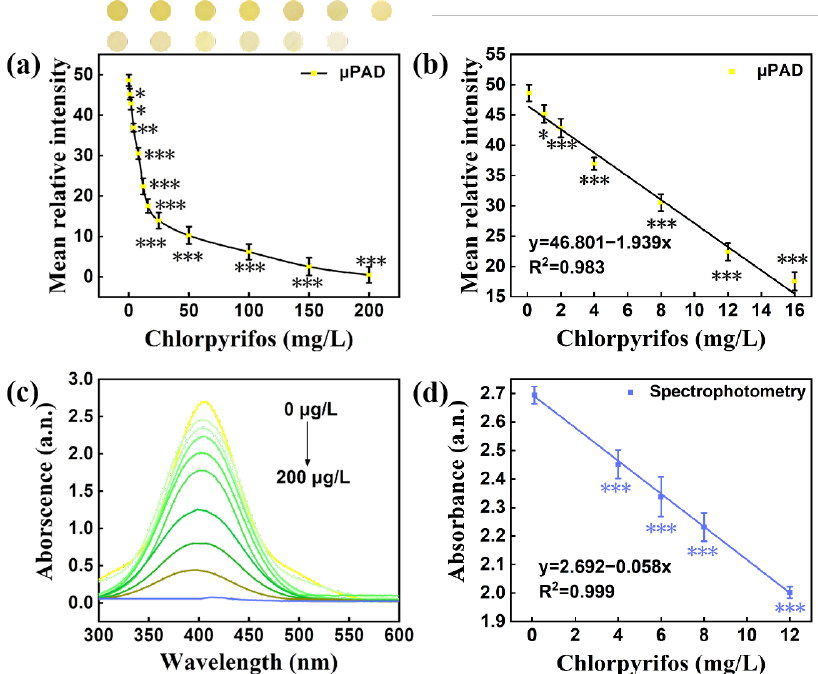
Figure 7. ( a ) The effect of different chlorpyrifos concentrations on the mean relative intensity of pSBMA-μPAD; ( b ) the correlation between the chlorpyrifos concentration and the mean relative intensity of pSBMA-μPAD; ( c ) absorbance of different chlorpyrifos concentrations at different wavelengths; ( d ) the chlorpyrifos concentration correlation between concentration and absorbance. “*” stands for significance test.